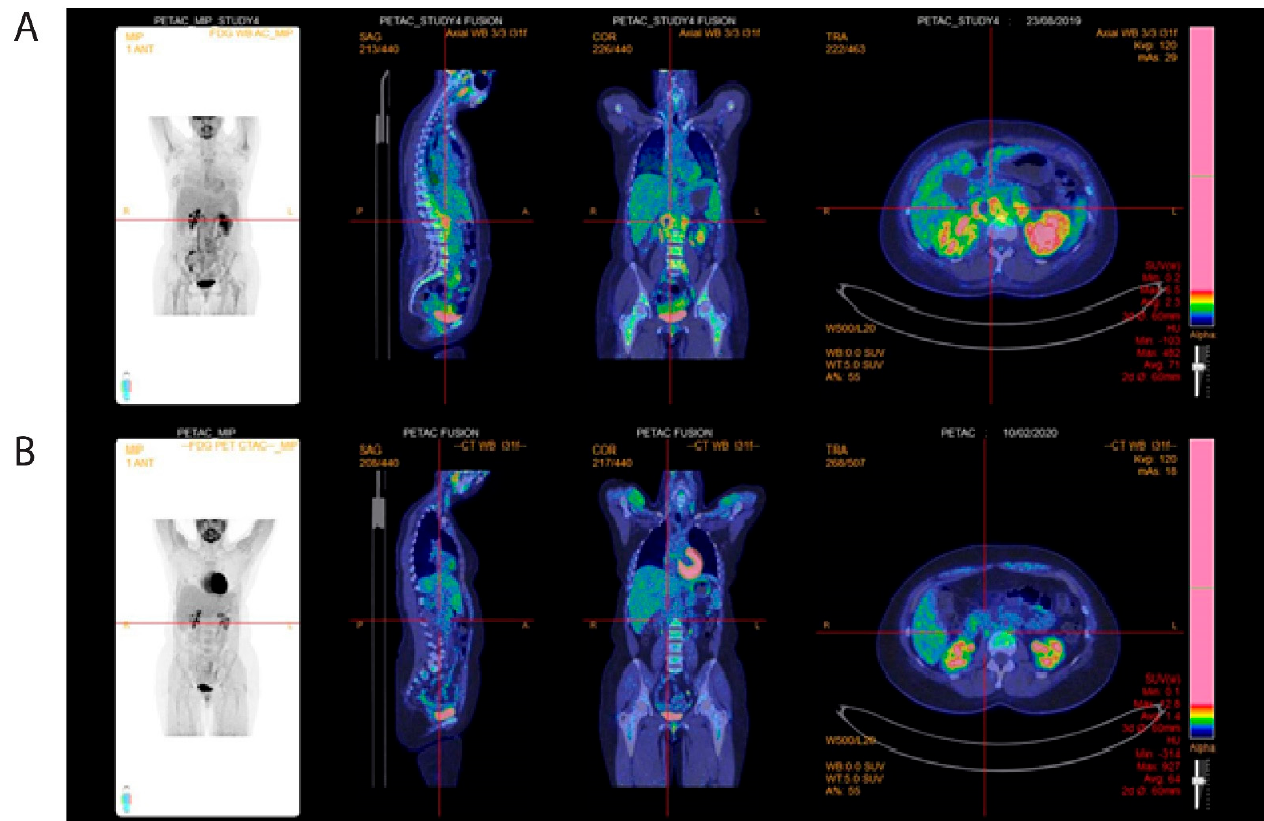
Figure 6. Posttreatment 18-fluorodeoxyglucose (FDG) positron emission tomography (PET)-computed tomography (CT) of abdomen. ( A ) [ 18 F]-FDG-PET/CT pre-therapeutic FDG-positive para-aortic masses. ( B ) After treatment showing metabolic complete remission.